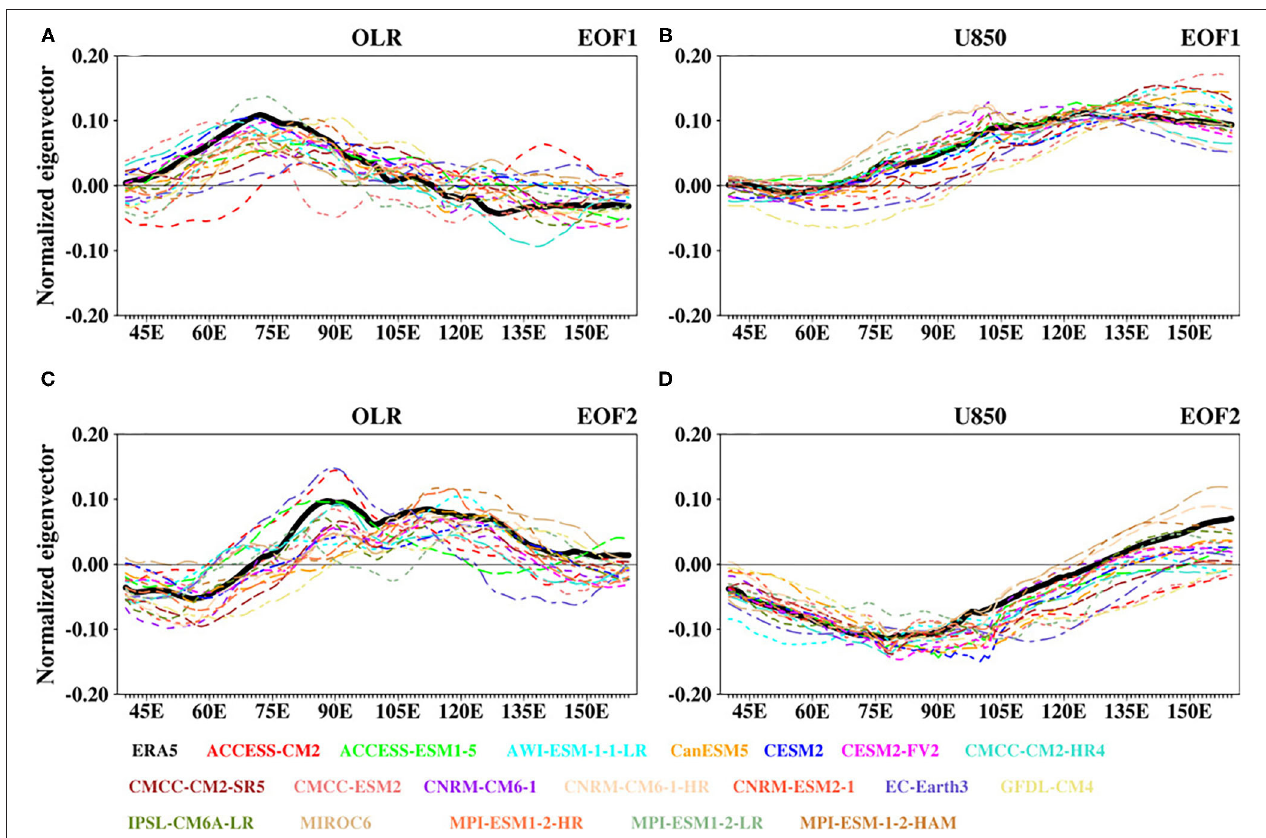
FIGURE 5 | The normalized eigenvectors of the first two leading modes of the combined empirical orthogonal functions (CEOFs) of 30–60-day 10 ◦ S − 30 ◦ N domain averaged OLR and U850 for ERA5 (solid black line) and CMIP6 models (dashed color lines). (A,B) are for the first mode and (C,D) are for the second mode. The sign and order of some of the simulated CEOFs are switched to resemble that of ERA5 (see section The CEOF and PC analyses for details).